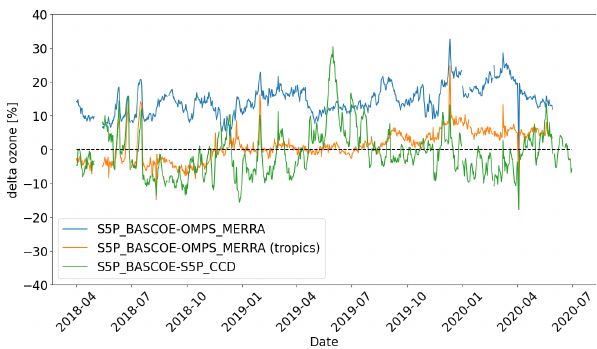
Figure 5. Time series of the differences between S5P-BASCOE against S5P_CCD (green), OMPS-MERRA-2 (blue), and the trop- ical subset of OMPS-MERRA-2 (orange). The CCD comparison focuses on the tropical region, while for the OMPS-MERRA-2 the global datasets were also considered. In the temporal mean a nega- tive bias ( ≈ 0 . 91DU or 0.81%) is found relative to CCD data and a positive bias (3.34DU or 14.59%) is found relative to OMPS-